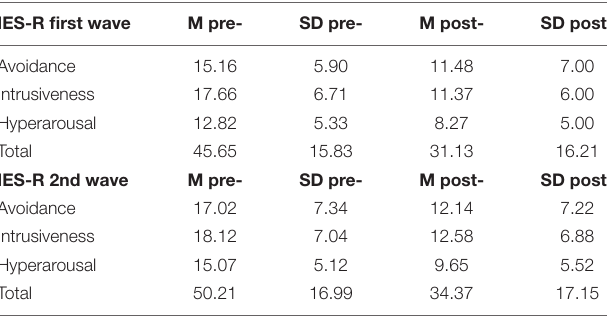
TABLE 2 | Impact of Event-Revised (IES-R) differences between before pre- and post-treatment. IES-R first wave